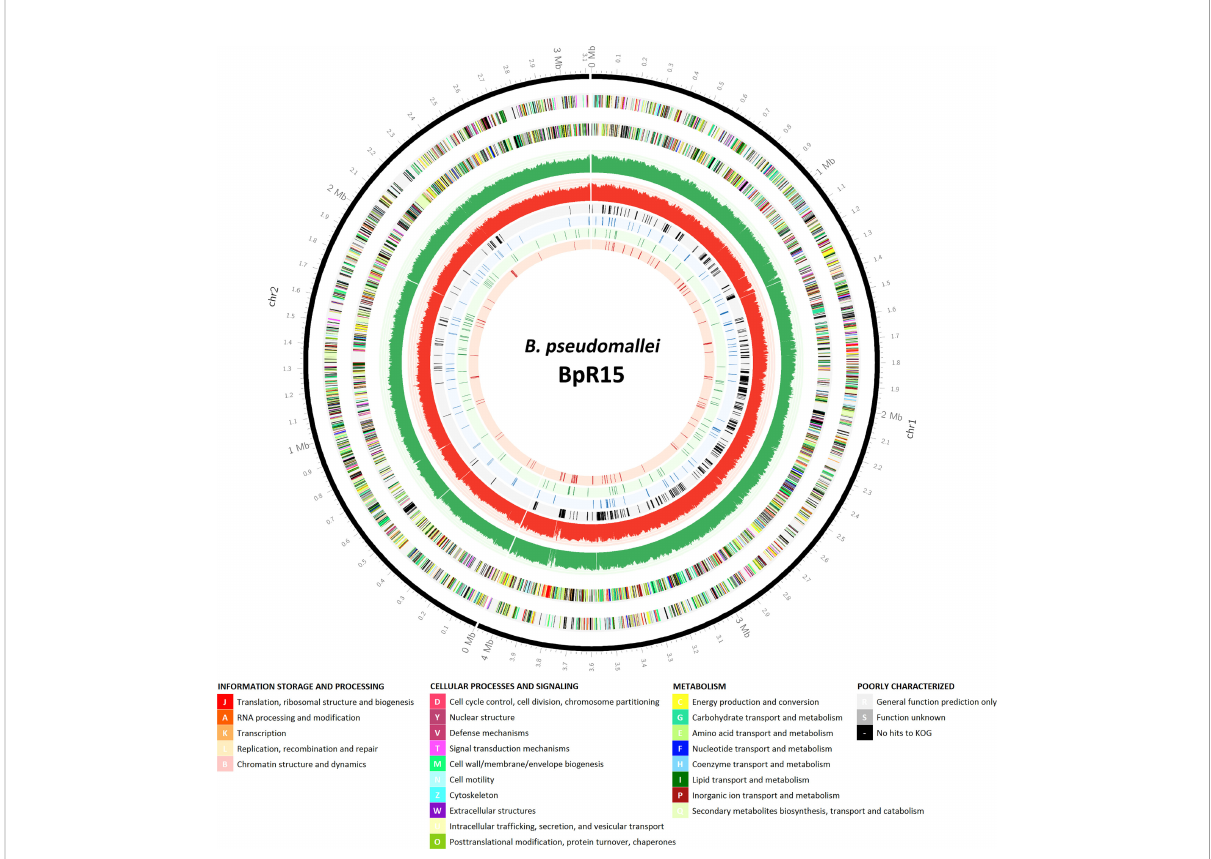
FIGURE 1 Genomic locations of the candidate essential genes of B. pseudomallei R15 and those associated with different in vitro conditions. An atlas representation of B. pseudomallei R15 genome, rings from outside to inside: track 1, base pair (bp) ruler; tracks 2 and 3, B. pseudomallei R15 CDS on the forward and reverse strands, respectively, with colors depicting COG categories (legend shown below); tracks 4 and 5, the number of TIS identi fi ed for the input pool over every 1000 bp (green: forward strand; red: reverse strand); tracks 6, 7, 8 and 9, essential genes predicted for input pool, general in vitro growth, LB-speci fi c and M9-speci fi c,